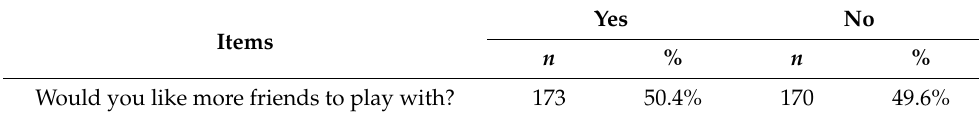
Table 5. Children’s social interactions in primary school in the pandemic—new